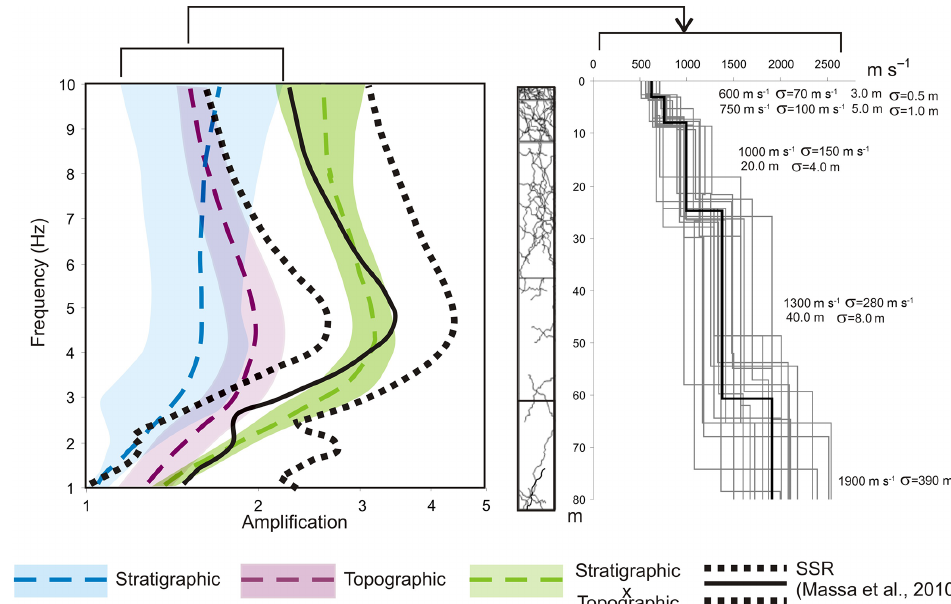
Figure 15. Seismic response by SiSeRHMap (linear analysis mode) in comparison to the SSR experimental